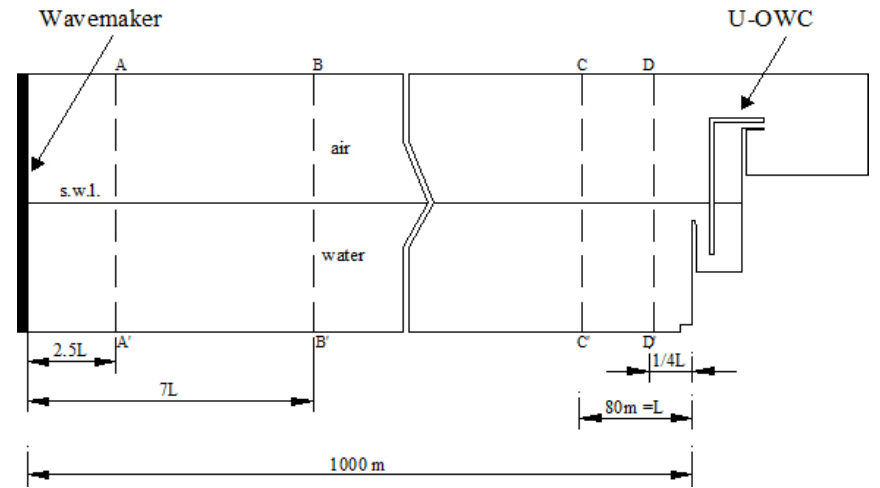
Figure 8. Vertical cross sections at different abscissas along the flume, where the energy flux is evaluated (distances, both from the wavemaker and the absorber, are referred to the wavelength L , of the wave train no. 7).